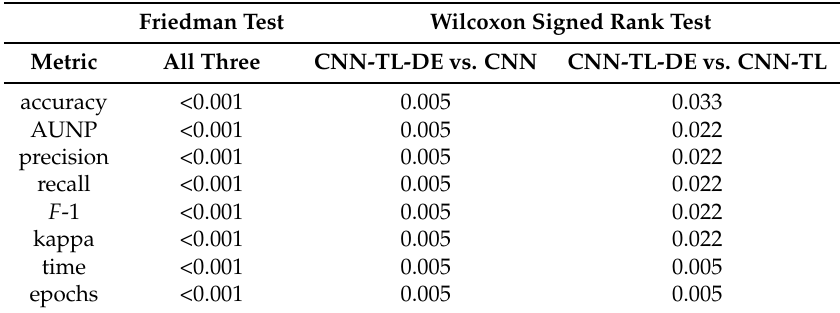
Table 5. Statistical comparison of the three compared methods (all results are statistically significant).